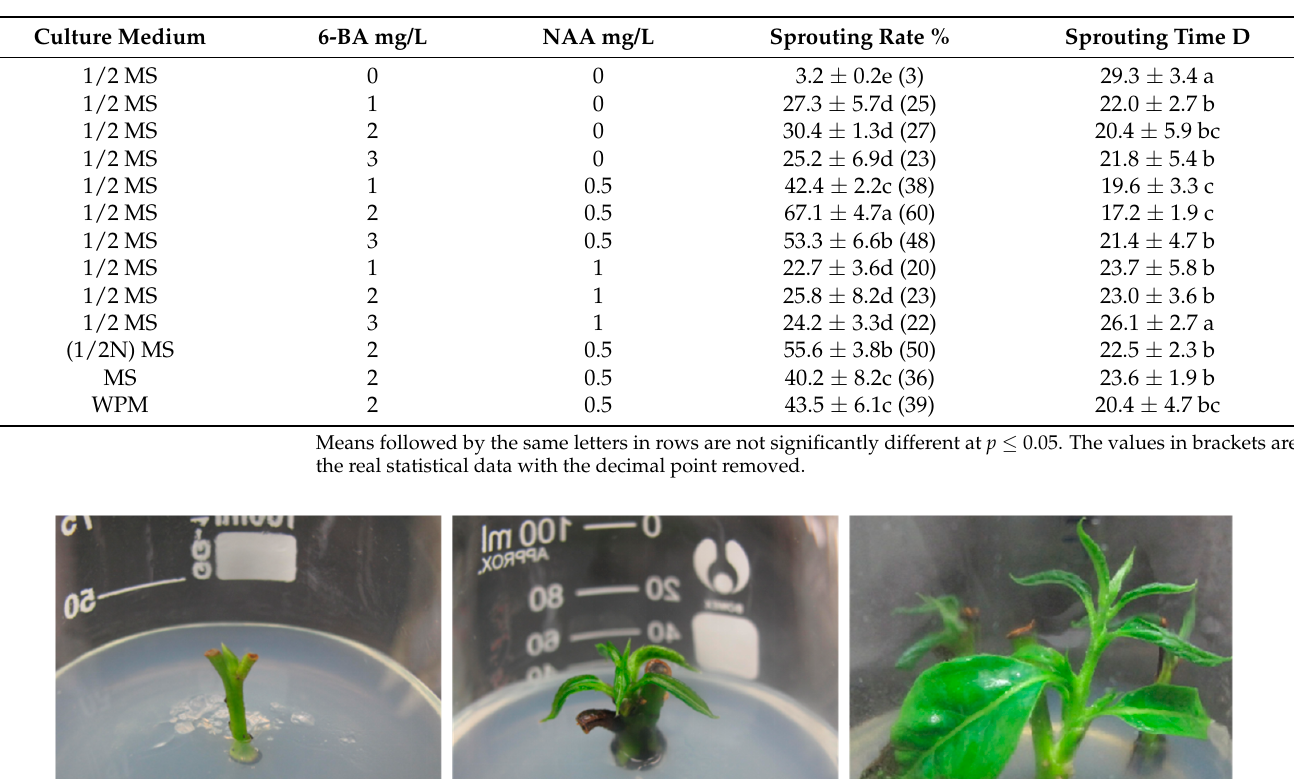
Table 2. Effects of different plant growth regulators and culture media on the primary culture of D. lotus stems with buds.